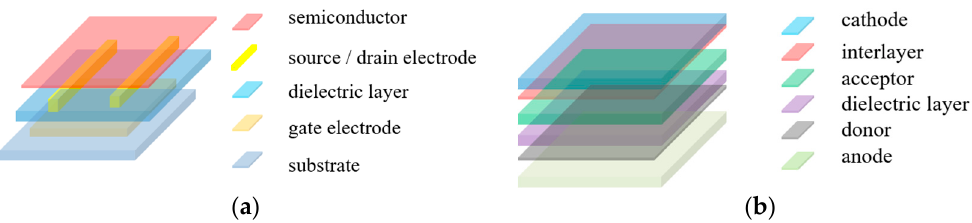
Figure 1. Schematic representation of an organic filed-effect transistors ( a ) and organic solar cells ( b ).